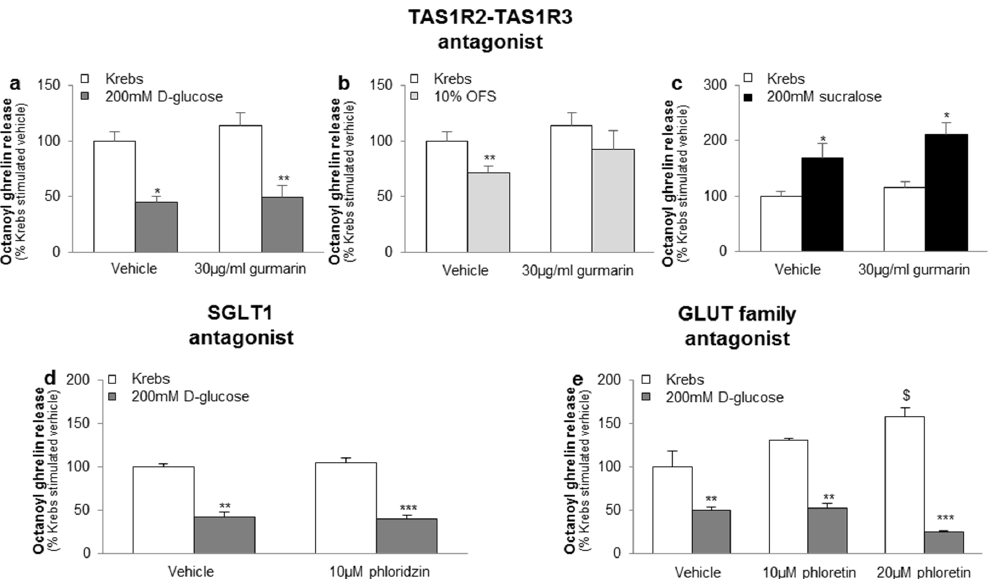
Figure 2. The effect of carbohydrates and sweeteners on octanoyl ghrelin release in the ghrelinoma cell line are not mediated via the sweet taste receptor or the glucose transporters. Effect of preincubation (30 min) of MGN3-1 cells with a ( a – c ) TAS1R2-TAS1R3 antagonist (gurmarin, 30 µ g/mL, n = 9); ( d ) SGLT1 inhibitor (phloridzin, 10 µ M, n = 9) or ( e ) GLUT family antagonist (phloretin, 10–20 µ M, n = 9) or their respective vehicle (Krebs with or without dimethylsulfoxide (DMSO)) on the effect of ( a , d , e ) 200 mM D -glucose; ( b ) 10% OFS; and ( c ) 200 mM sucralose compared to Krebs buffer on octanoyl ghrelin release in MGN3-1 cells. Results (mean ± SEM) are expressed relative to the control stimulation (Krebs buffer containing 11.1 mM D -glucose). * p < 0.05, ** p < 0.01, *** p < 0.001 vs. vehicle, $ p < 0.05 vs. vehicle stimulated